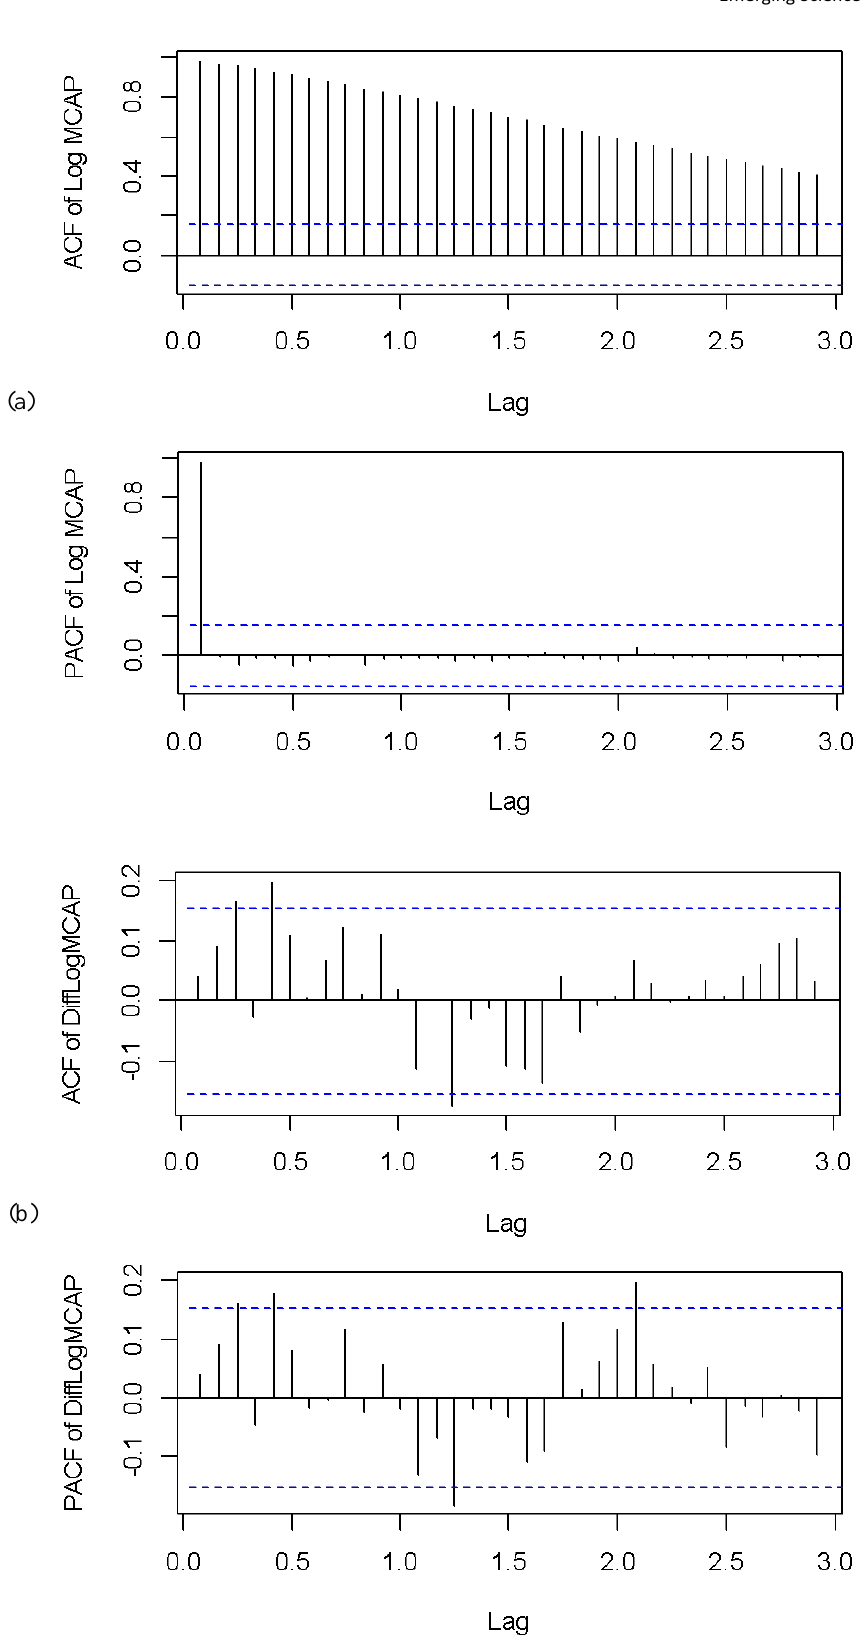
Figure 4. The ACF and PACF plot for the time series (a) natural logarithmic of Market capitalization data (LogMCAP) and (b) natural logarithmic return (first differenced) of Market capitalization data (DiffLogMCAP) Akaike Information Criterion (AIC) is used for different values of p and q to choose the best ARIMA model calculated (Table